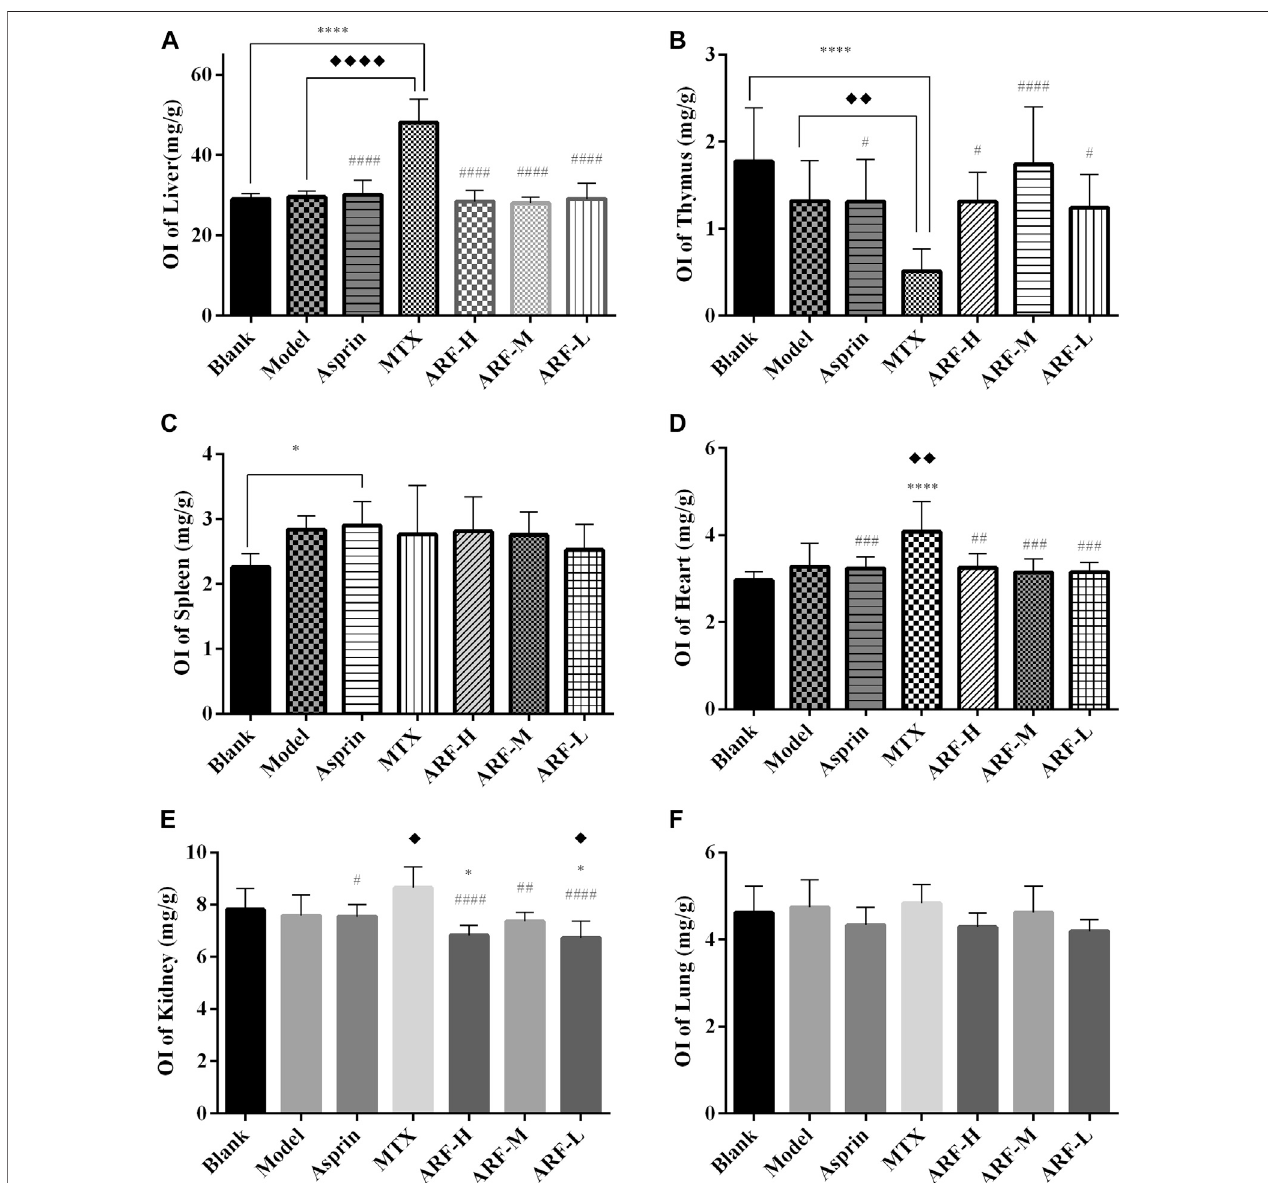
FIGURE 4 | After 21 days of treatment, the effects of each treatment group on the indexes of the thymus, spleen, liver, heart, kidneys, and lungs in AIA model rats. (A) liver, (B) thymus, (C) spleen, (D) heart, (E) kidneys, and (F) lungs. The treatment groups vs. Blank group, * p < 0.05, ** p < 0.01, *** p < 0.001, **** p < 0.001. Data are exhibited as mean ± SD ( n (cid:1) 8). Comparison with the Model group, ◆ p < 0.05. Contrasted with the MTX group, # p < 0.05, ## p < 0.01, #### p < 0.001.